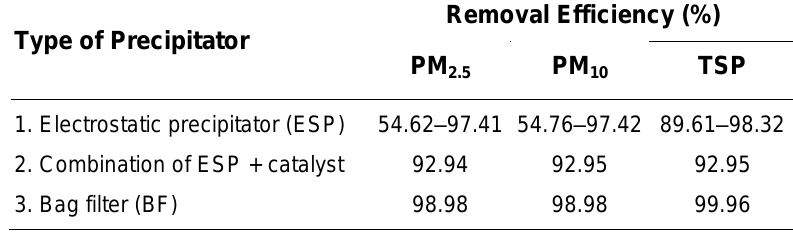
Removal Efficiency of PM According to Precipitator